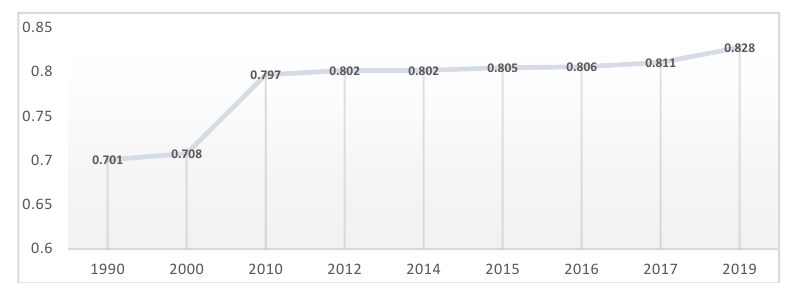
Figure 1. Human Development Index (HDI). Source: computed by authors using HDI [21].